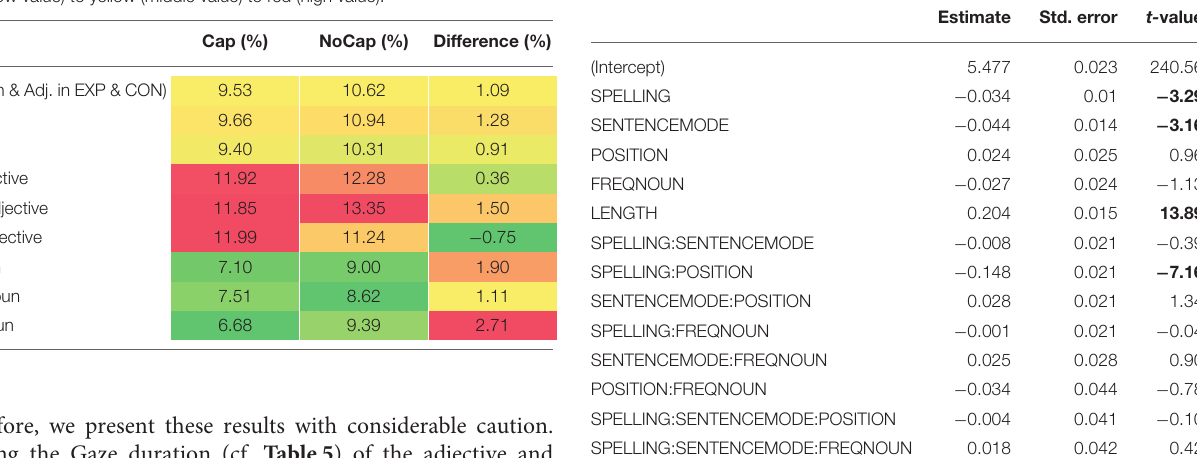
TABLE 4 | Descriptive statistics: probability of receiving at least one regression from a higher Interest Area (word from the right); colors are shading from dark green (low value) to yellow (middle value) to red (high value).